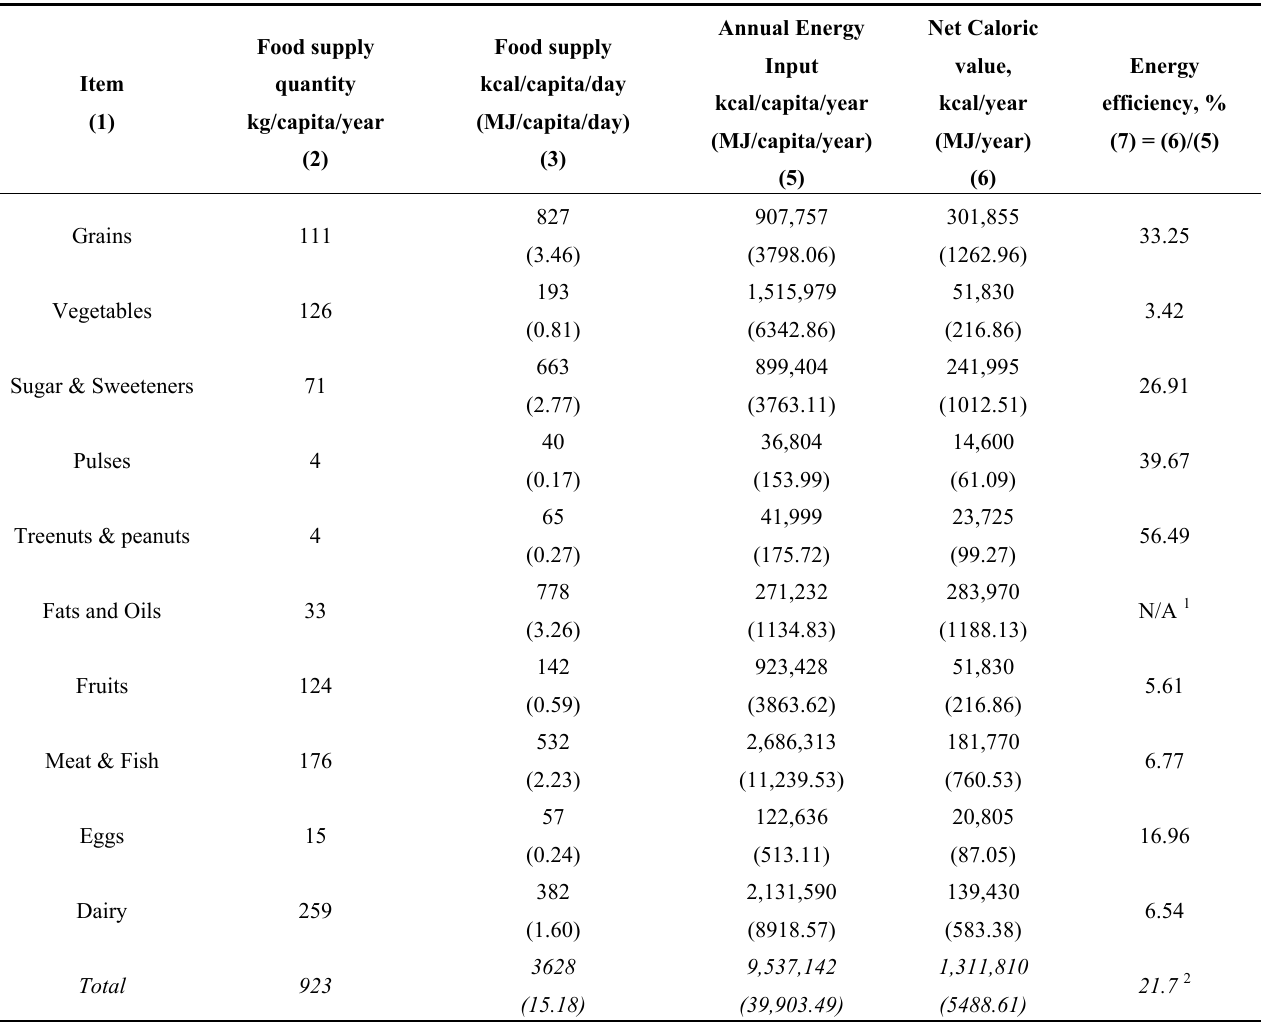
Table 5. Food supply and energy efficiency for a typical American diet for the year 2004